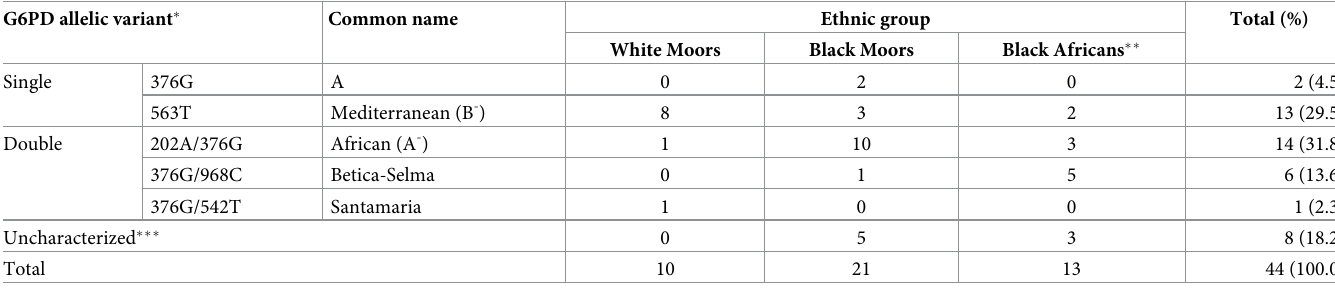
Table 2. G6PD allelic variants among phenotypically deficient male blood donors by ethnic group in Nouakchott, Mauritania. G6PD allelic variant